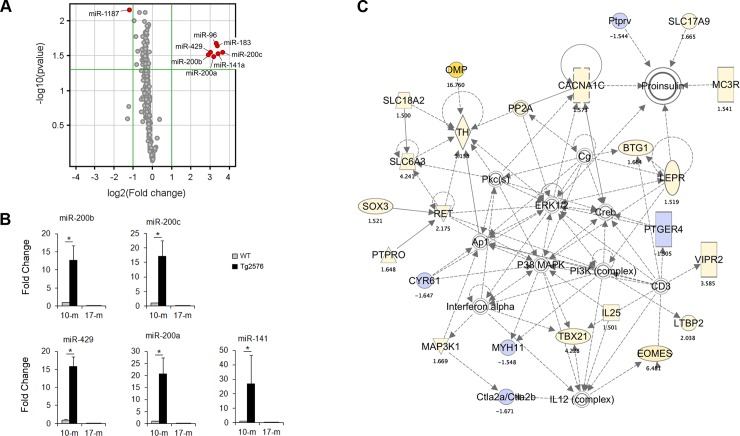
The members of the miR-200 family and related differentially expressed mRNA network are implicated in insulin signaling in the cortex of 10-month-old Tg2576 mice.(A) Volcano plot showing microarray data of significantly upregulated miRNAs in the cortices of 10-month-old (10 mo.) Tg2576 mice as compared to wild-type (WT) mice. The threshold values for fold change were set at > 2 or < 0.5 (outside the vertical lines) and P value < 0.05 (above the horizontal line); red points in the plots represent the significant differentially expressed miRNA. The miRNAs that were upregulated were members of the miR-200 and miR-183 families. (B) qRT-PCR was used to validate the upregulation of miR-200 family members using TaqMan assays. The upregulation of members of this miRNA family was confined to the 10 mo. period, a phase during which Aβ accumulation increases. (C) The top network of differentially expressed mRNA as identified by IPA analysis of the microarray data. Up- and down- regulated genes are colored in yellow and blue, respectively. Solid and dashed arrows indicate direct and indirect connections, respectively. Subscripted numbers indicate fold change. The network involves components of the insulin signaling pathway.